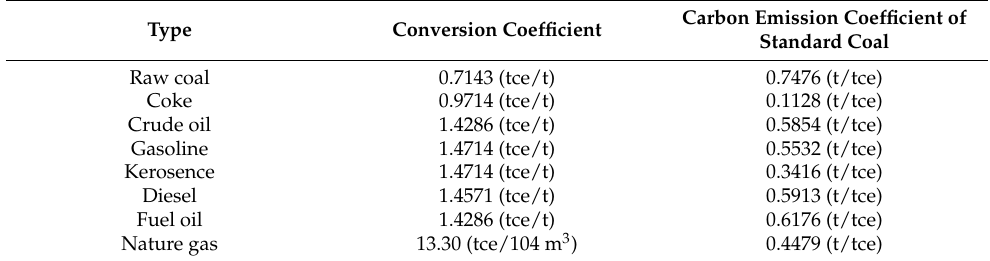
Table A3. Conversion coefficient and carbon emission coefficient of standard coal.